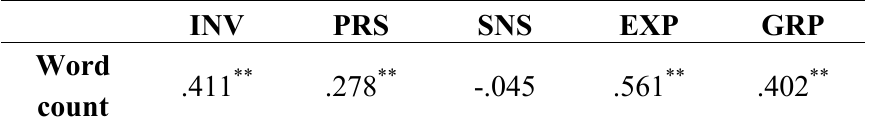
Correlations between word count and features of WTC INV PRS SNS EXP Word count